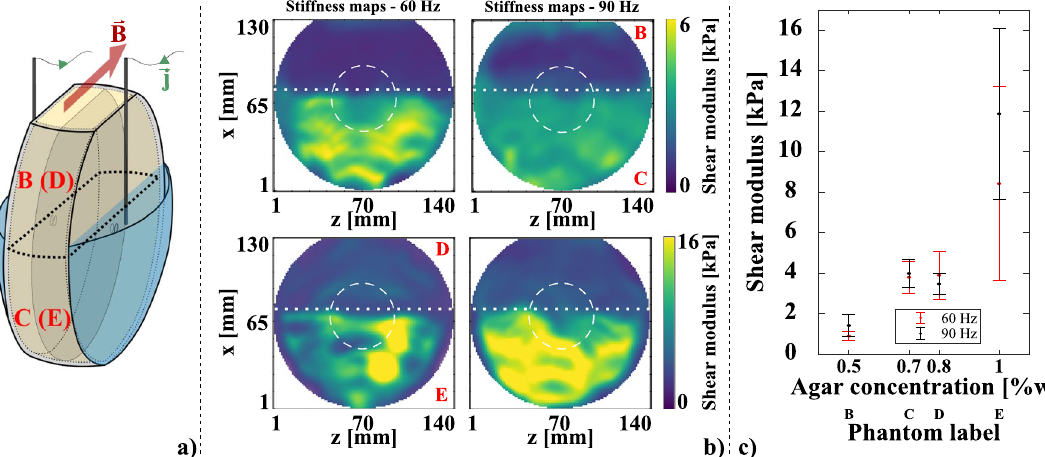
Figure 5. Second experiment. ( a ) Phantoms arrangement: B (D) on top of C (E). Phantom separation is indicated by the thick black dashed line. The greyed-out sagittal plane is the acquisition plane. ( b ) Stiffness maps from harmonic actuations at 60 Hz and 90 Hz with a current intensity of 62 mA peak-to-peak in phantoms B, C, D, and E. Mean values and standard deviations were calculated in compartments separated by the dotted line. The dashed circle indicates the region where the magnitude of the Lorentz force density drops from its maximum value to 1/10th of this maximum. ( c ) Mean shear storage moduli in phantoms B, C, D, and E. Error bars correspond to standard deviations. The separation between lower and higher parts of phantoms on stiffness maps, which corresponds to higher and lower agar concentrations, respectively, is clearly visible in panel ( b